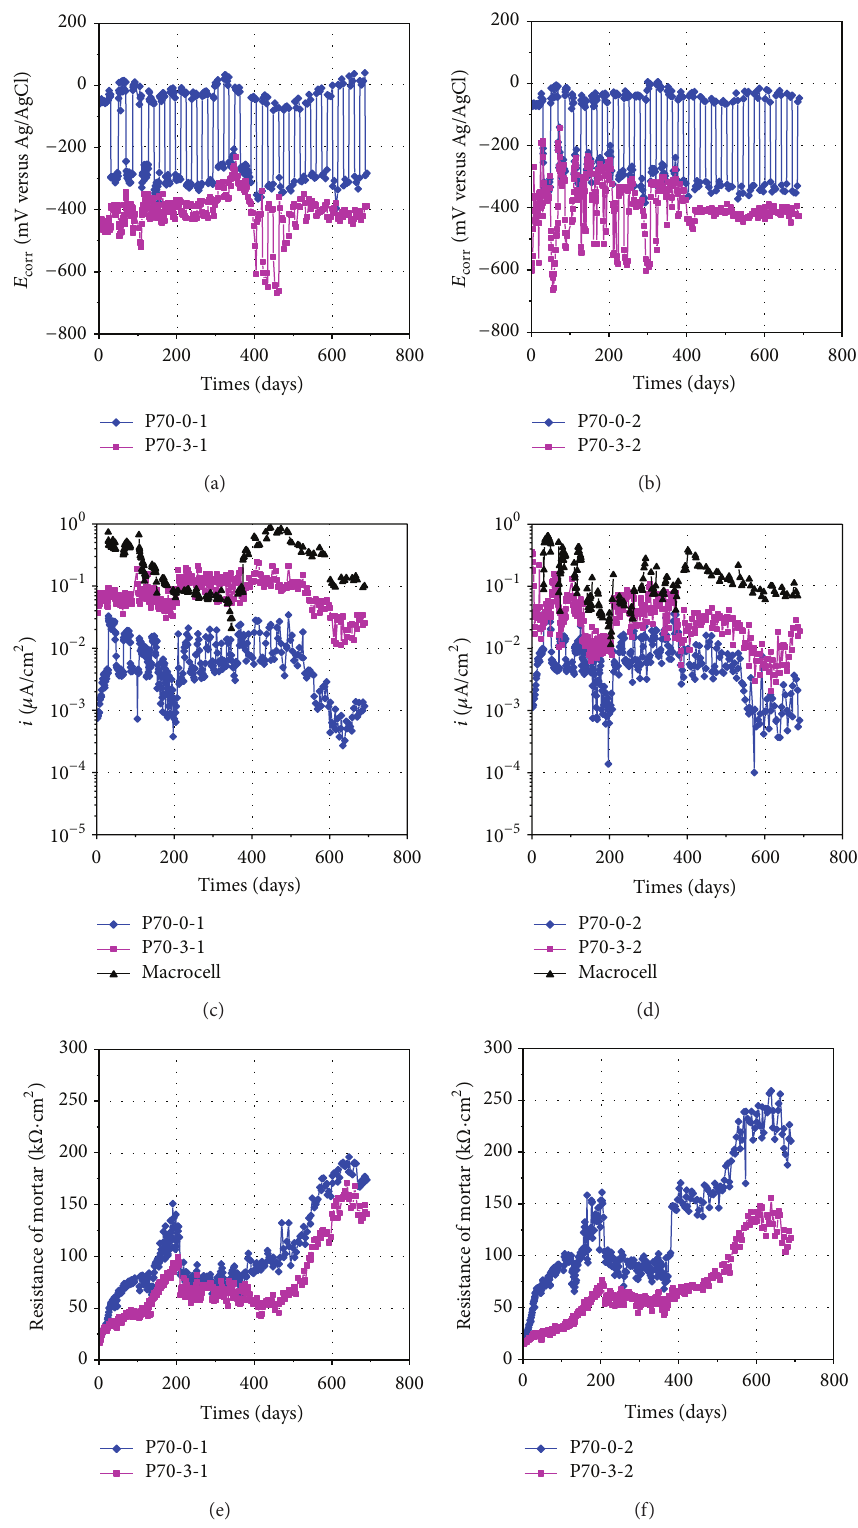
Figure 5: Time evolution curves of half-cell potential, microcell current density, macrocell current density, and resistance of mortars for cases with W/C ratio of 0.70. (a) Half-cell potential of steel in case 11-1, (b) half-cell potential of steel in case 11-2, (c) corrosion current density of steel in case 11-1, (d) corrosion current density of steel in case 11-2, (e) resistance of mortar in case 11-1, and (f) resistance of mortar in case